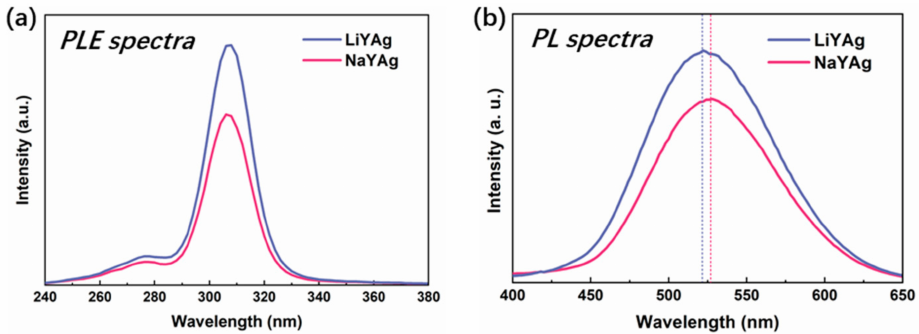
Figure 2. PLE ( a ) and PL ( b ) spectra of Ag CLs in LiYAg and NaYAg, respectively, under 306 nm excitation; inset: corresponding normalized PL